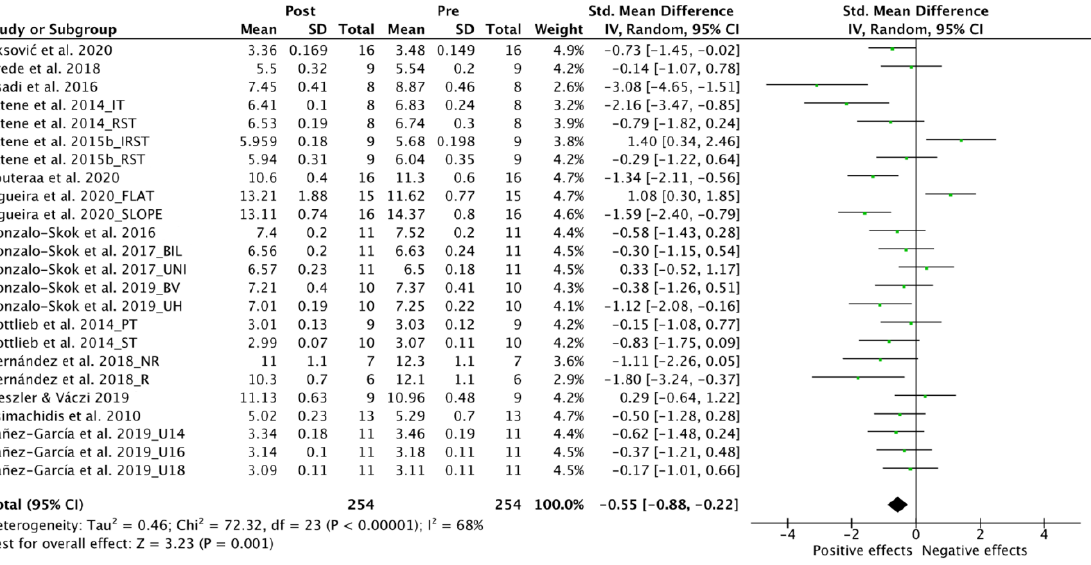
Figure 5. Forest Plot comparing the effect of multidisciplinary interventions on neuromuscular power horizontal (NPH) [49 – 51,61,62,64 – 68,70,71,74,77,78].